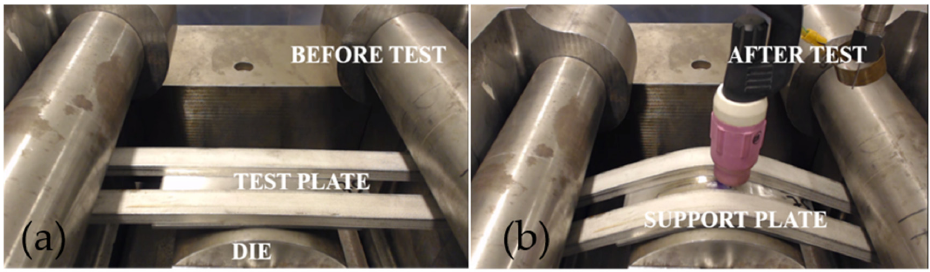
Figure 1. Varestraint testing setup ( a ) before and ( b ) after test.